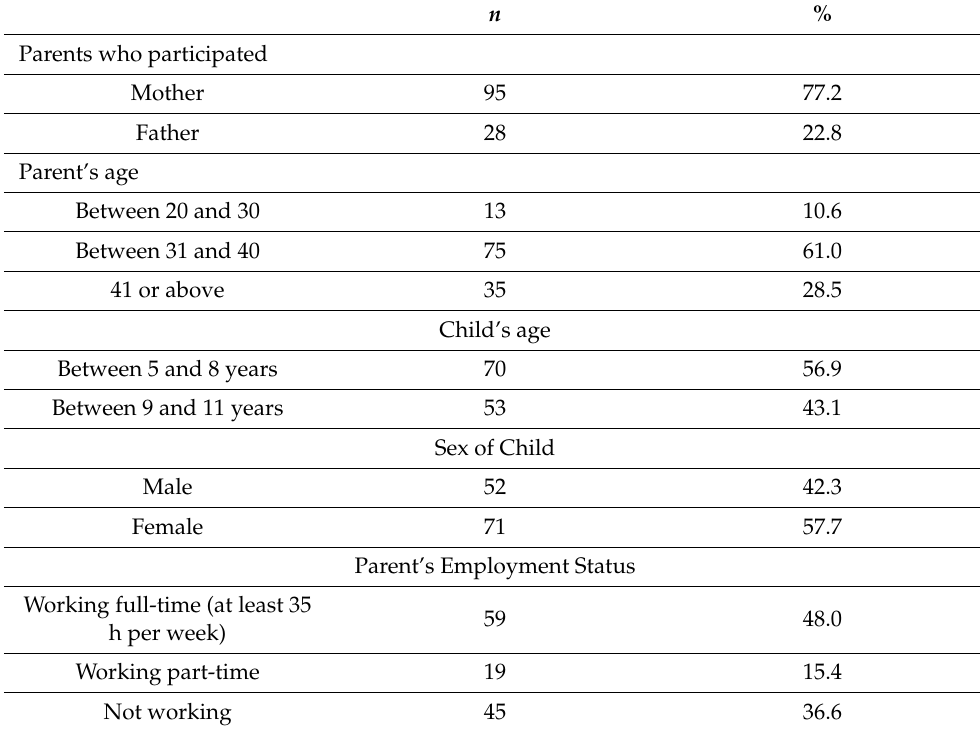
Table 1. Demographic